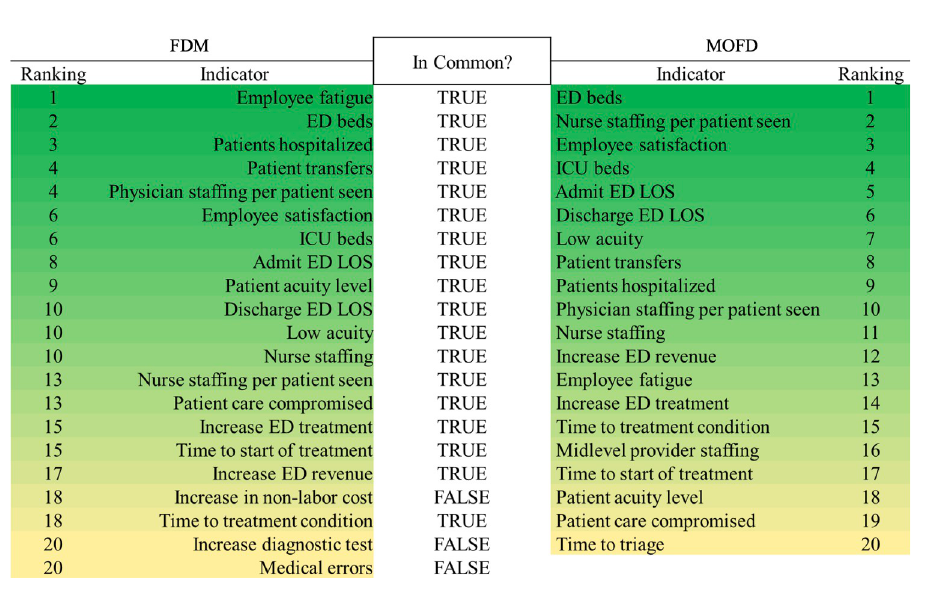
Furthermore, the hypothesis test demonstrated that the panelists’ scores are stable, which means a convergence of the MOFD process. Finally, 21 performance indicators were retained in the FDM, and 20 were retained for MOFD to measure the performance of the EDs during a medical surge using the consensus views of the medical professionals. Fig 2 presents the final list of indicators and compares the results of the two methods.